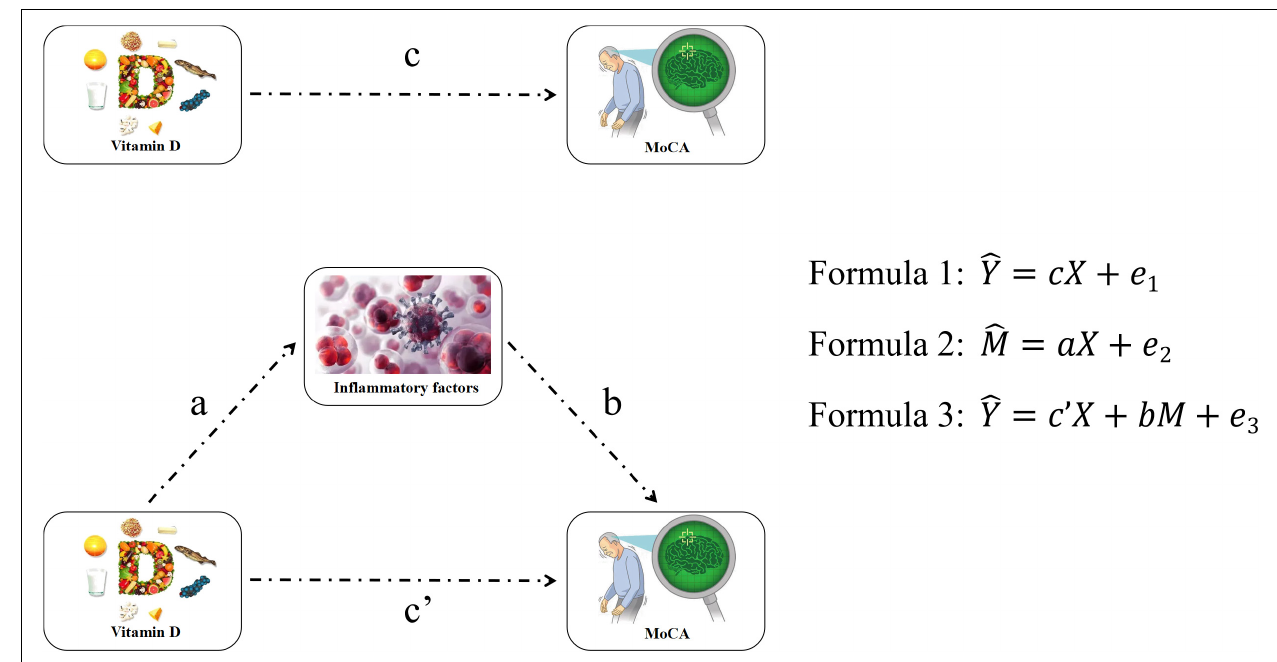
FIGURE 1 | Flow of mediation effect analysis. Y , X , and M are MoCA scale score, VD, and inflammatory factors concentration, respectively. a, b, c, c (cid:48) , e 1 , e 2 , and e 3 are equation parameters.